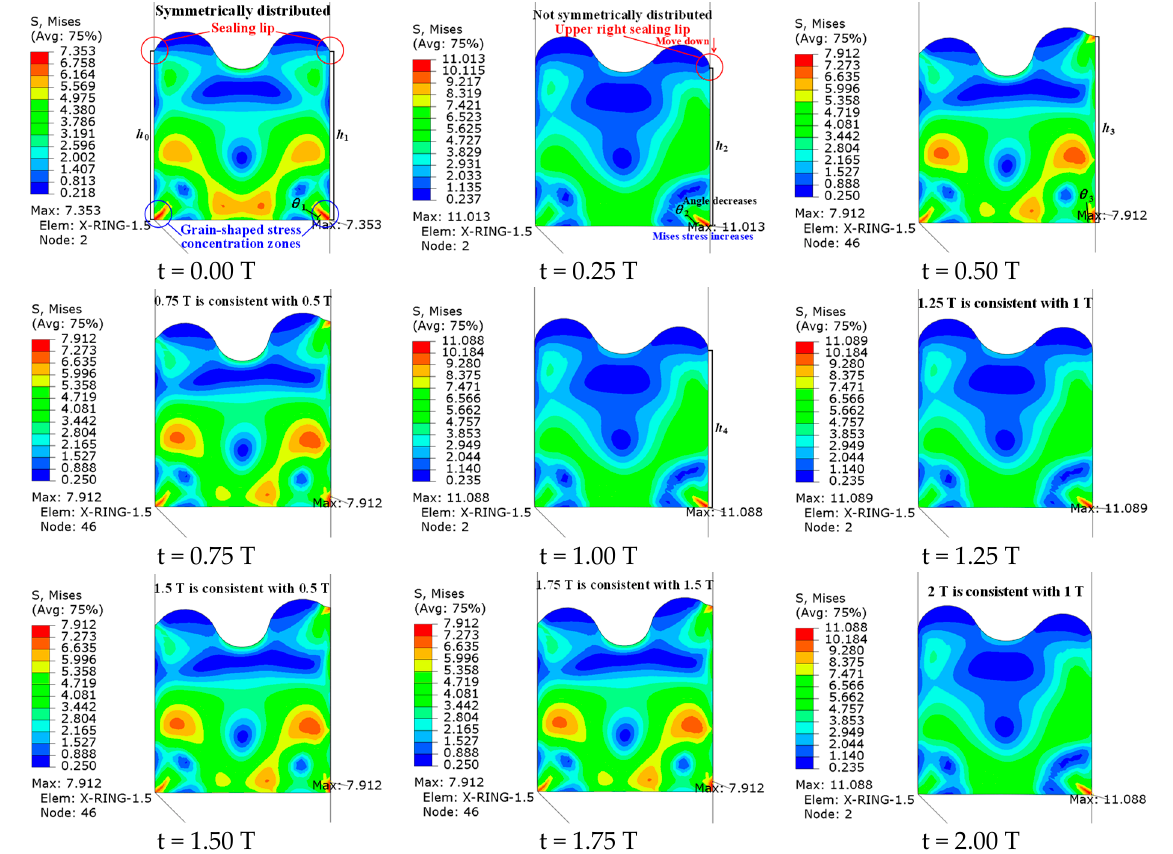
Figure 5. Mises stress distribution during 0–2 T. In 0.25–0.5 T, the cover moves along + y , creating + y friction on the X-ring and dragging the X-ring to move together along + y . As the X-ring moves upward, the height increment of the upper right sealing lip during 0.25–0.5 T ( h 3 − h 2 ) exceeds the height reduction during 0–0.25 T ( h 1 − h 2 ) due to the weakening of the blocking effect of the wedge-ring. Accordingly, the height of the upper right sealing lip at 0.5 T ( h 3 ) is significantly higher than the initial height at 0 T ( h 1 ). At the same time, due to the weakening of the blocking effect of the wedge-ring, the angle increment of the lower right stress concentration zone with the upper surface of the wedge-ring during 0.25–0.5 T ( θ 3 − θ 2 ) exceeds the angle reduction during 0–0.25 T ( θ 1 − θ 2 ). Therefore, at 0.5 T, the angle between the grain-shaped stress concentration zone in the lower right corner and the upper surface of the wedge-ring ( θ 3 ) is substantially more significant than the initial angle at 0 T ( θ 1 ). Consequently, the grain-shaped stress concentration zone is almost close to the surface of the cover.